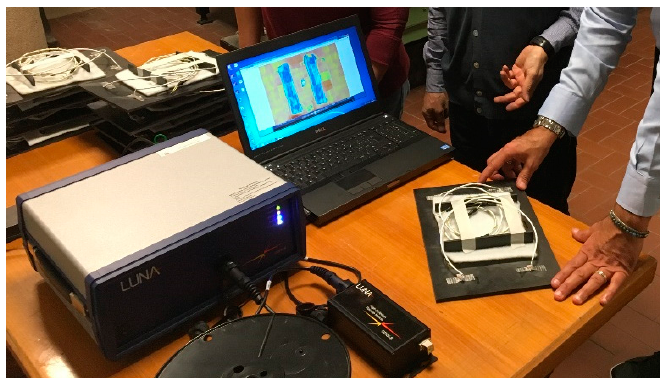
Figure 5. Fiber optic sensor interrogation unit.